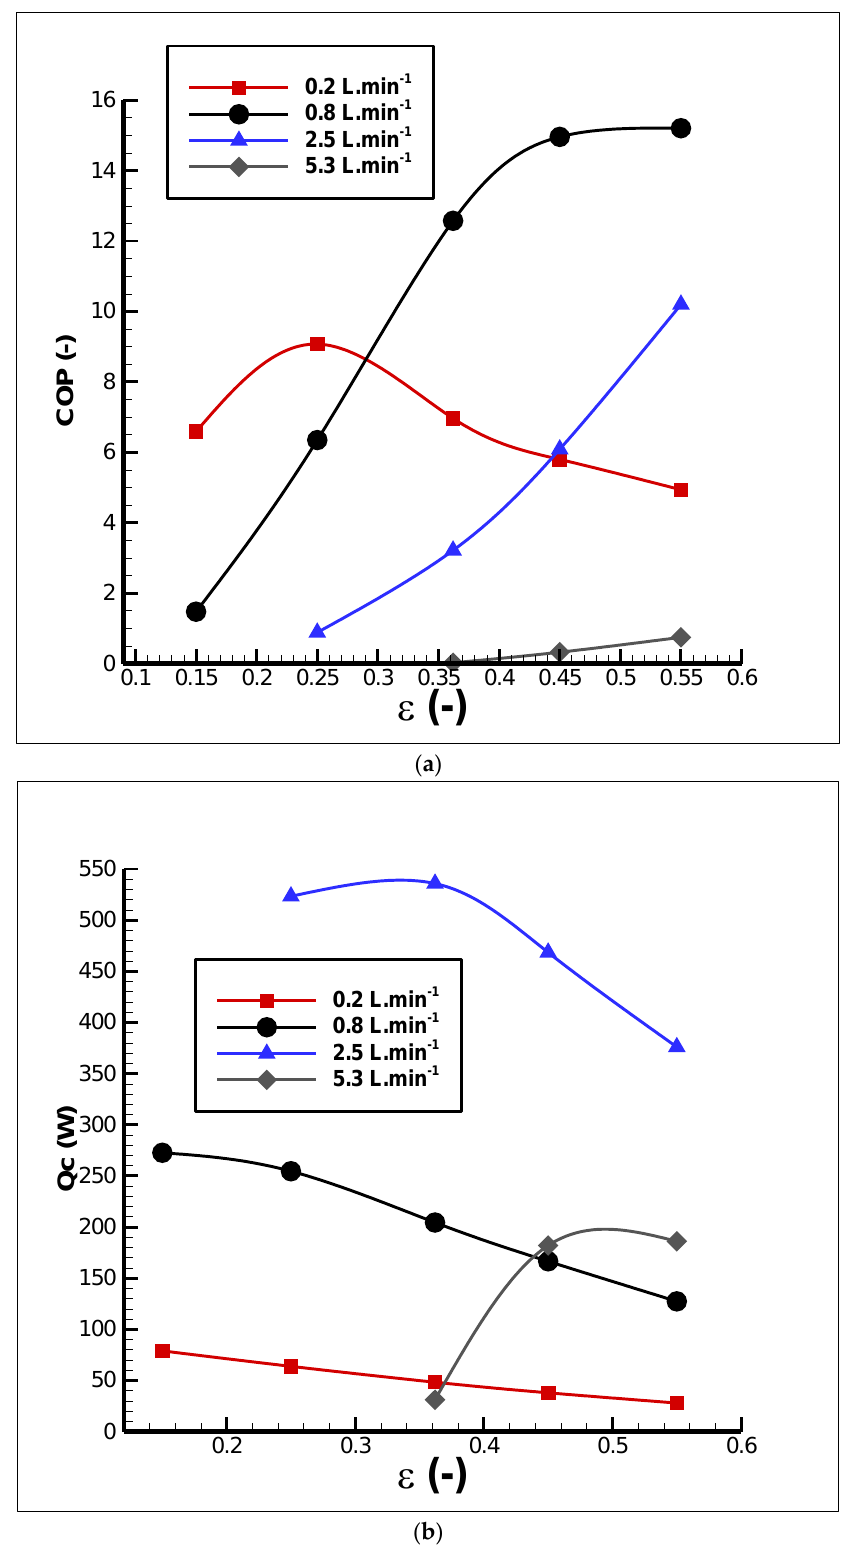
Figure 12. Chart of ( a ) the coefficient of performance and ( b ) refrigeration capacity based on porosity for a temperature range of 1 K, frequency of 4 Hz, and a sphere diameter of 0.5 mm at different volumetric flow rates.